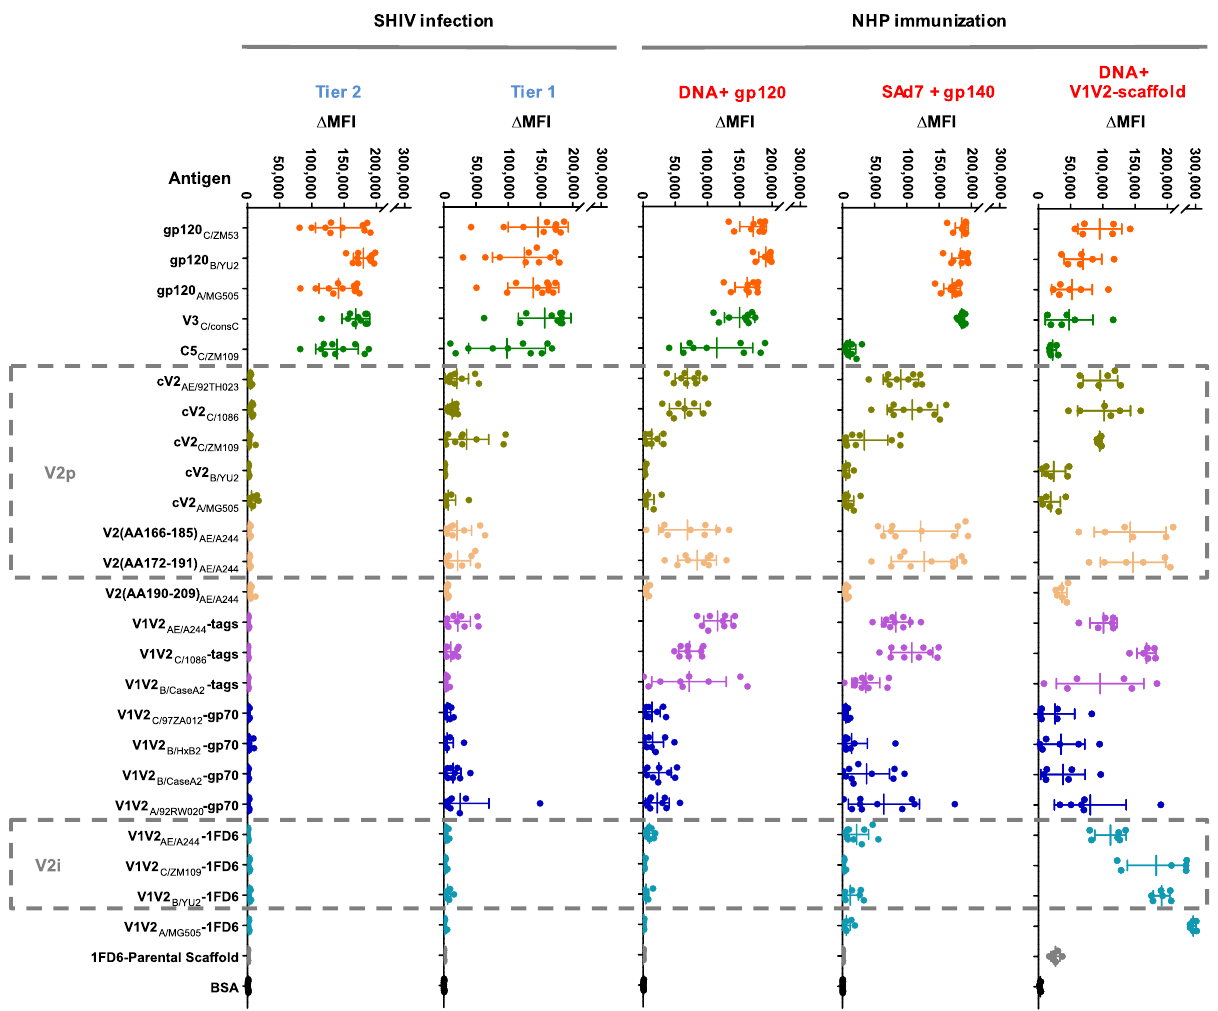
Fig. 3 Dot plot of Ab binding activities in plasma from infected and immunized NHPs assessed in the multiplex bead Ab binding assay. Columns from left to right: Tier 2 SHIV C/1157-ipd3N4 -infected NHPs ( n = 10); Tier 1 SHIV C/1157ipEL-p -infected NHPs ( n = 10); NHPs immunized with “ DNA + gp120 ” ( n = 9); NHPs immunized with “ SAd7 + gp140 ” ( n = 10); NHPs immunized with “ DNA + V1V2-scaffolds ” ( n = 6). Each group was composed of biologically independent plasma specimens. Binding activity of plasma was measured against the same set of 24 Env antigens used in Fig. 1a; each row lists a tested antigen, and the rows are grouped by antigen type (peptide; gp120, etc.). Boxes with dashed lines denote antigens reactive with V2p- or V2i-speci fi c mAbs. Beads identi fi ed as “ 1FD6 parental scaffold ” (devoid of the V1V2 insert) and BSA (bovine serum albumin) were used as negative controls. Each dot represents the normalized mean fl uorescence intensity ( Δ MFI) generated with a plasma specimen diluted 1:200 from a single animal. Error bars indicate mean and standard deviation (SD). Colors of the dots represents a type of antigen (orange = gp120s, dark green = non-V1V2 linear peptides (V3 and C5), olive green = cV2 peptides, cream = linear V2 peptides, purple = V1V2-tags, dark blue = V1V2-gp70s, light blue = V1V2-1FD6s, gray/black = negative controls). Intensity of the reactivity is shown as the mean MFI calculated from experiments normalized on the basis of the reactivity of the mAb pool in each experiment from which background (PBS-TB) was subtracted. Data are represented as mean with error bars that indicate standard deviation (SD). Experiments were performed at least twice and in each experiment, samples were tested in duplicate. Source data are provided as a Source Data fi le. Abbreviations as in Fig.